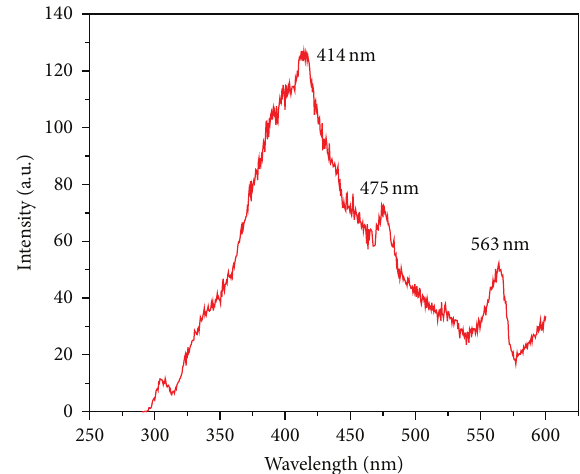
Figure 8: PL spectra of microwave synthesized ZrO 2 sample excited at wavelength 270